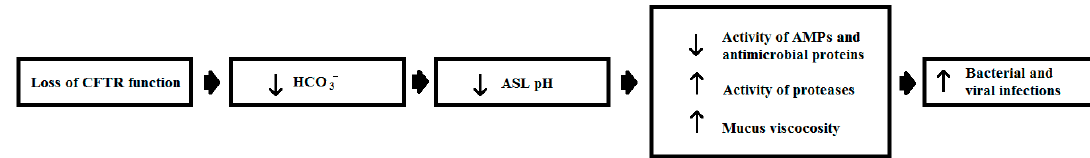
Figure 3 . The pH of airway surface liquid and the pathogenesis of cystic fibrosis. Figure 3 was revised from [165] and shows a scheme for how changes in airway surface liquid (ASL) pH may influence the pathogenesis of cystic fibrosis (CF). In CF, the loss of cystic fibrosis transmembrane conductance regulator (CFTR) function results in decreased HCO 3 − conductance across airway epithelial cells and leads to low pH in the ASL. Under these pH conditions, ASL AMPs, such as LL-37, HNP-1, HBD-1 and lactoferrin, and antimicrobial proteins, such as lysozyme, surfactant protein A and surfactant protein D, have reduced activity. Lower pH also leads to the increased viscosity of mucins, decreased ciliary beat frequency, impaired phagocyte function and depleted ASL volume. These effects lead to a decrease in the antimicrobial efficacy of the ASL and subsequently contribute to increased respiratory infections in the CF airway, caused by both viral and bacterial pathogens [165,166,179,185].